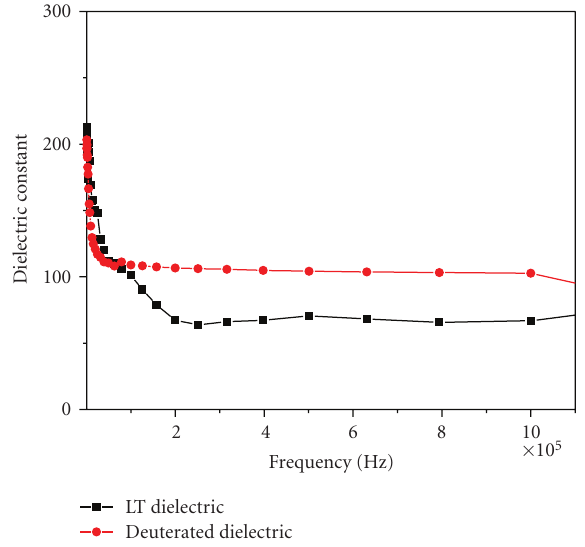
Figure 33: Dielectric constant of pure and deuterated L-threonine single crystal at various frequencies.